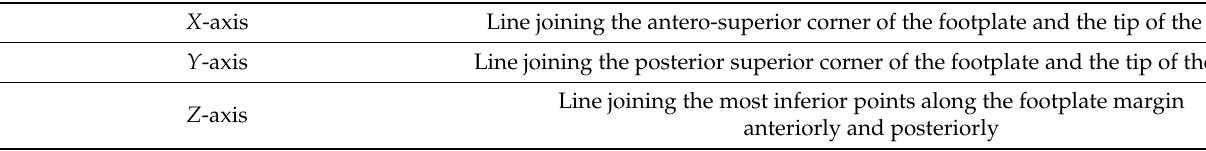
Table 3. Measurement protocol and indices for the stapes